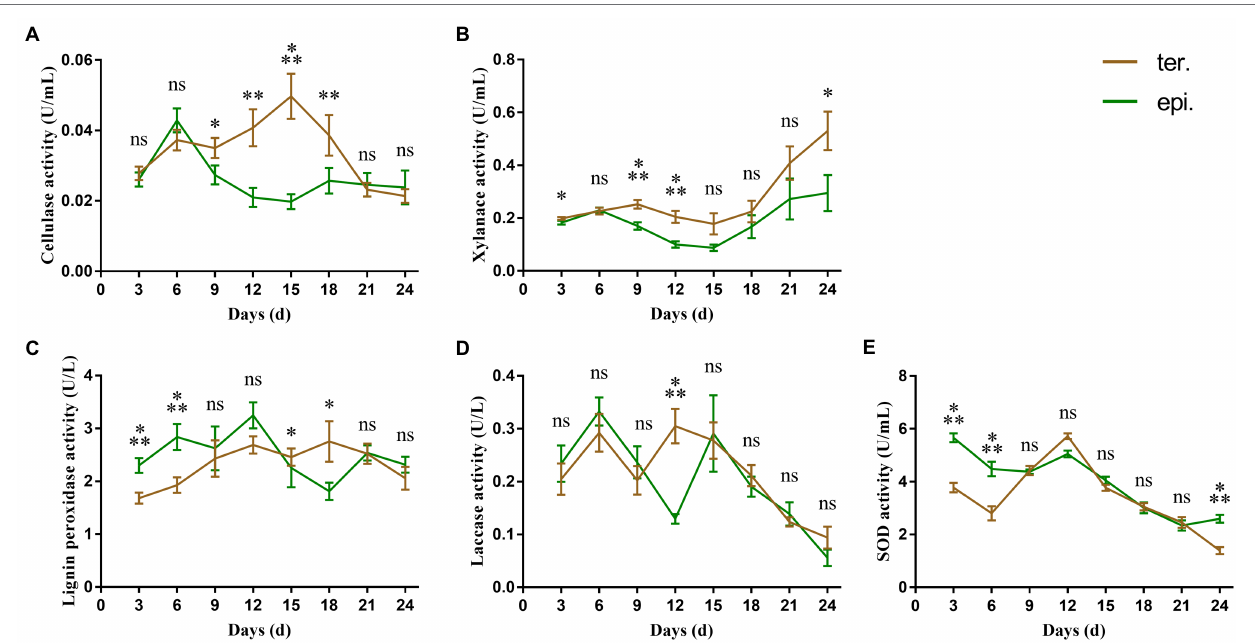
FIGURE 1 | Extracellular enzyme activities of 24 different Tulasnellaceae spp. The green line connects the average enzyme activities of epiphytic fungi at different time points, while the brown line connects the average enzyme activities of terrestrial fungi. Error bar represent the SEM. (A) cellulase; (B) xylanase; (C) lignin peroxidase; (D) laccase; and (E) superoxide dismutase. ns, not significant; * p < 0.05; ** p < 0.01; and *** p <